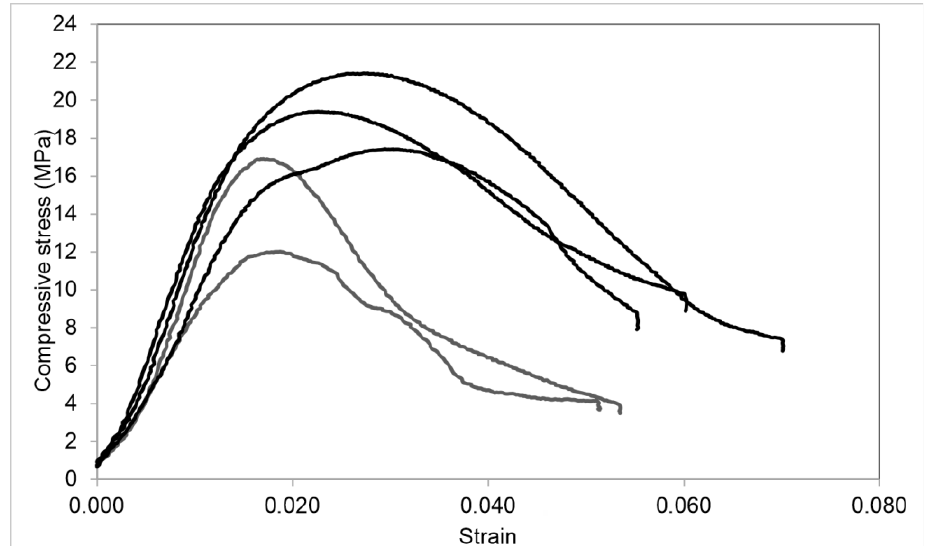
Figure 8. The results of uniaxial compression tests with loading rate of 0.5 mm/min: black curves — stress-strain diagrams for the sand reinforced by the sequential pumping of small volumes of components A and B with a retention of the system under pressure after each stage and their extrusion with the compressed nitrogen rock (the injection scheme is shown in Figure 4a); grey curves — stress-strain diagrams for the sand reinforced by the stepwise injection of the full volumes of components A and B into the rock and their extrusion by compressed nitrogen deep into the rock (the injection scheme is shown in Figure 4b).